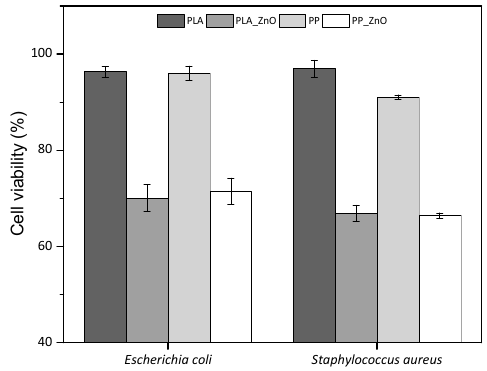
Figure 23. Bacteria cell viability after 24 h treatment with coated and noncoated PLA and PP films. There is no significant difference in the antimicrobial activity between E. coli and S. aureus ( p < 0.05).